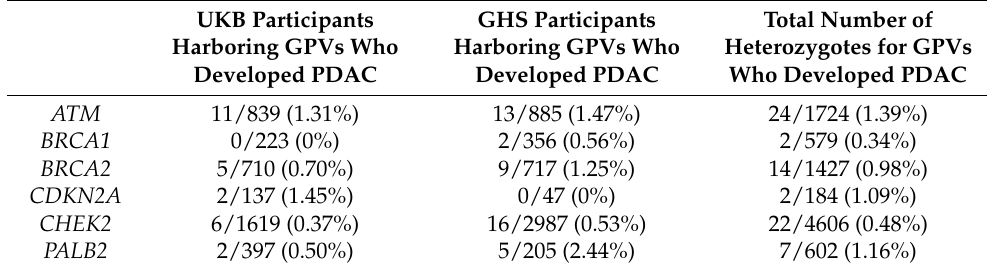
Table 3. Prevalence of PDAC in participants harboring a GPV (i.e., heterozygous) by gene.